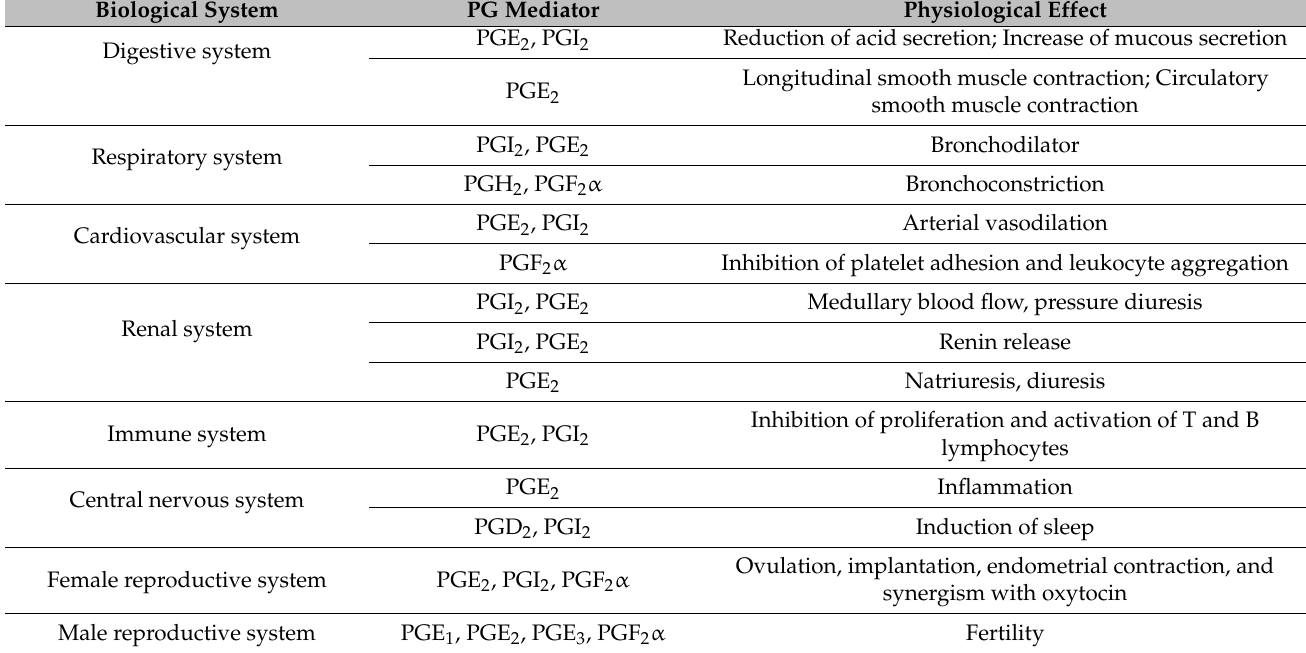
Table 1. Summary of prostaglandin (PG) general